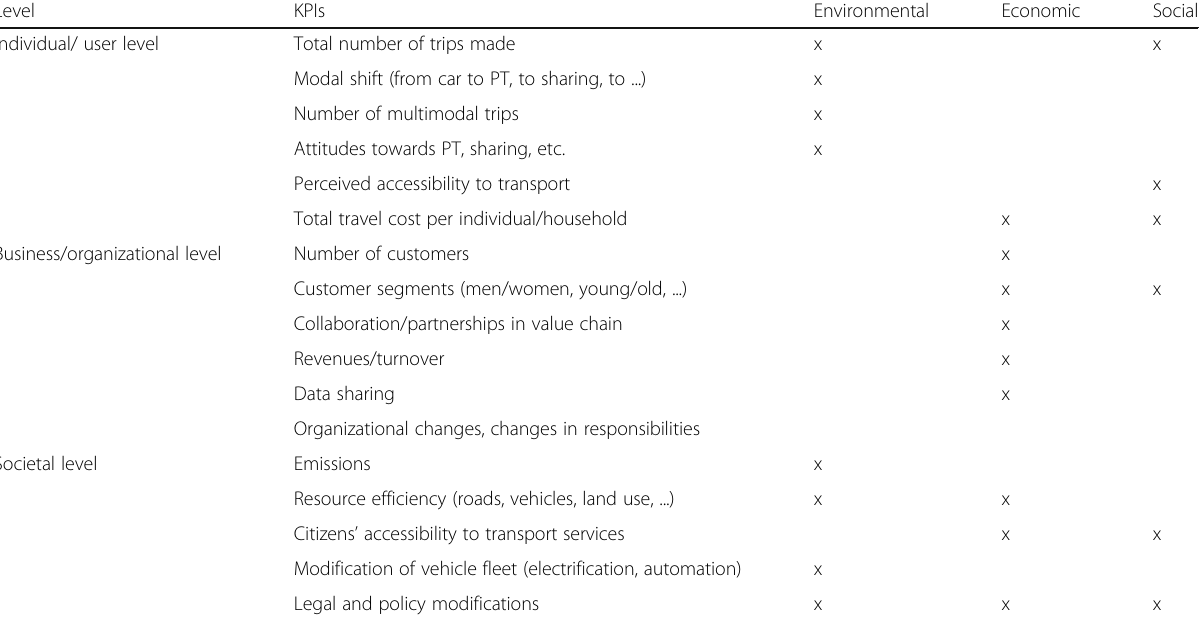
Table 1 Impact assessment framework